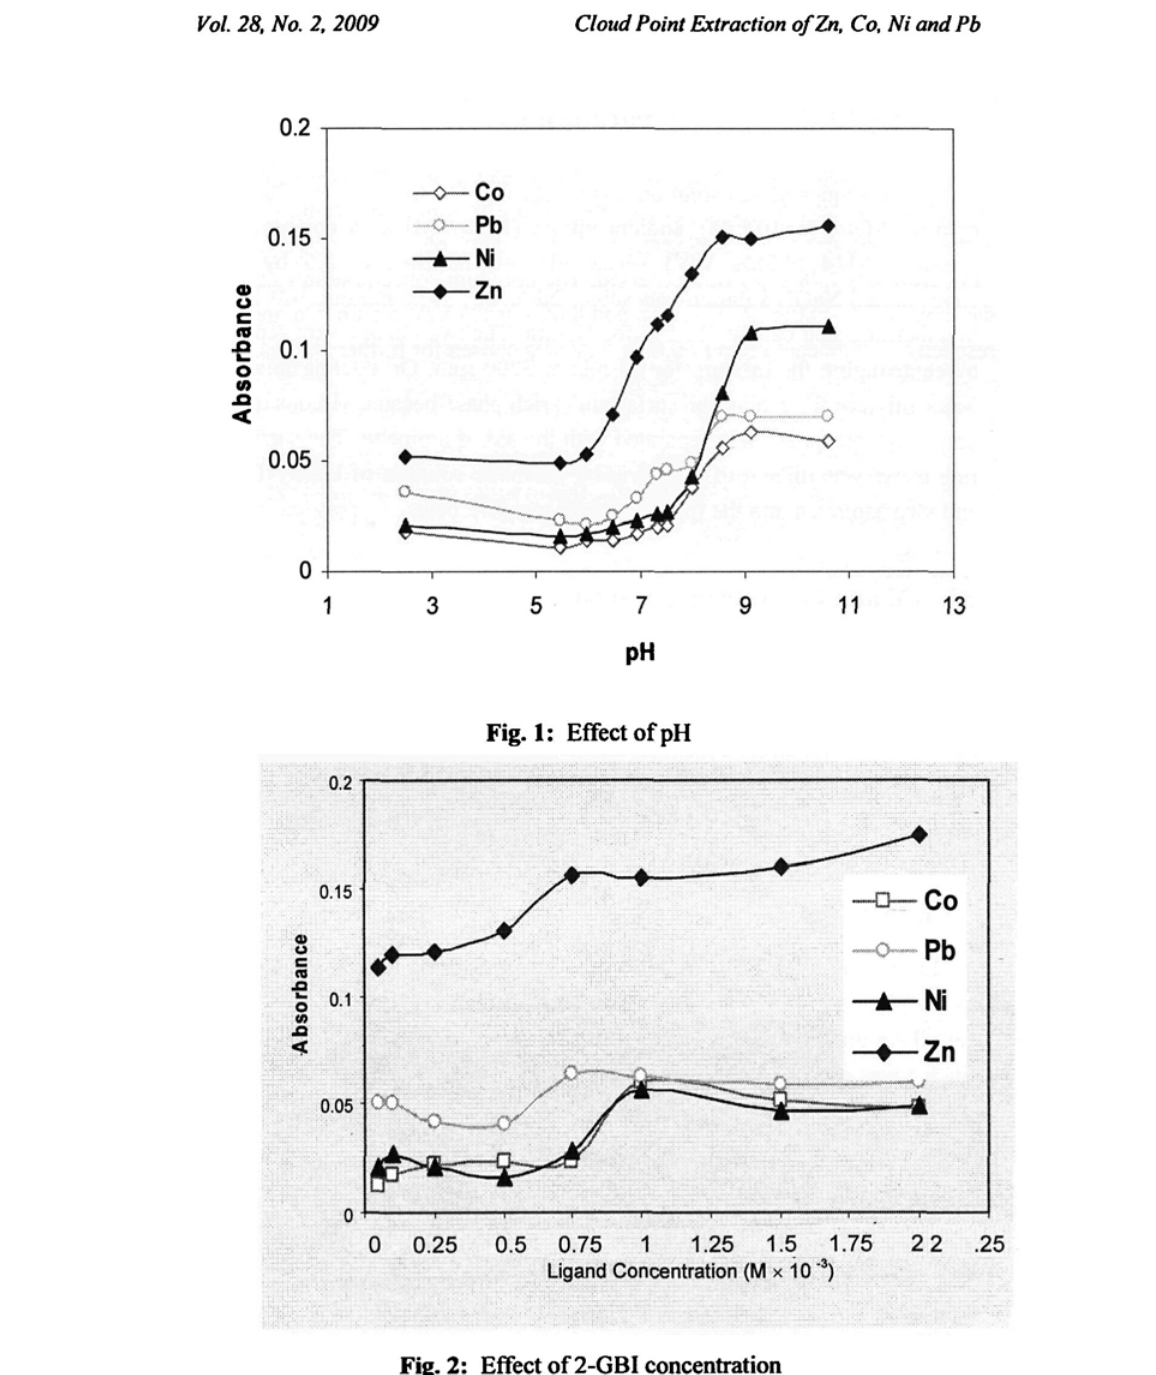
Fig. 2: Effect of 2-GBI